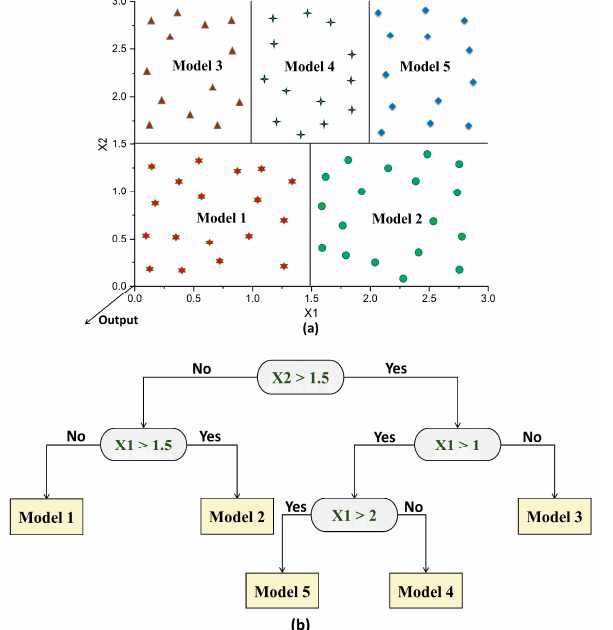
Figure 3. Illustration of the M5 algorithm: ( a ) splitting of the input space; ( b ) building of the tree.